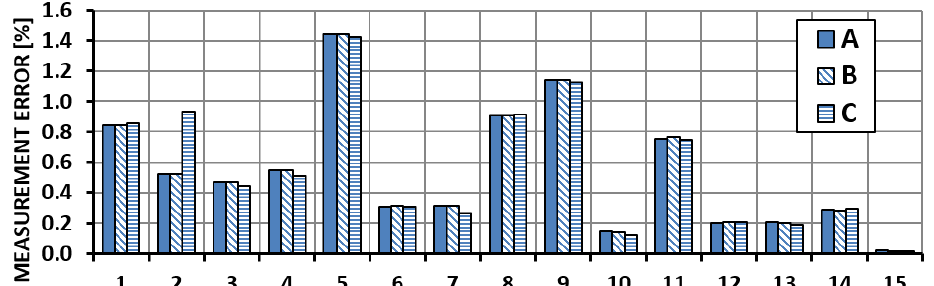
Figure 11. Bending moment measurement error—Section III.